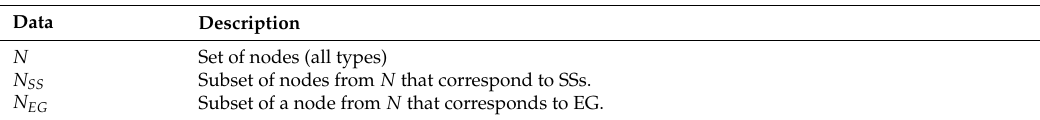
Table 11. Summary of input data